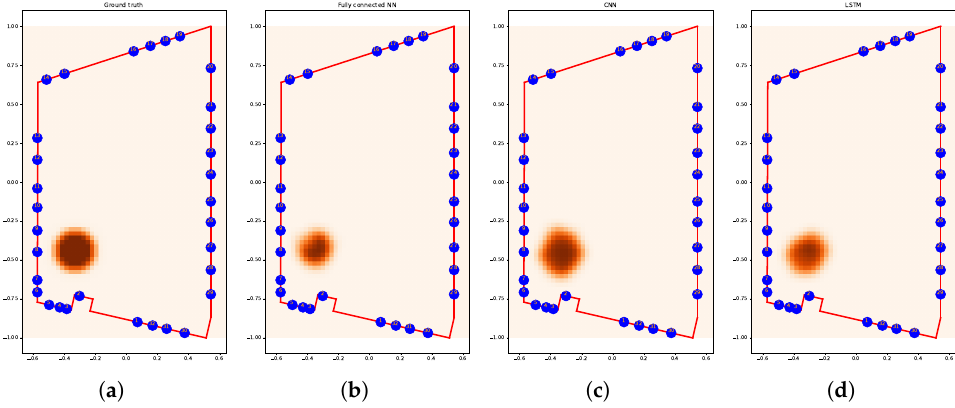
Figure 14. Reconstructions from the first test measurement. ( a ) Ground truth. ( b ) Fully connected NN. ( c ) CNN. ( d )